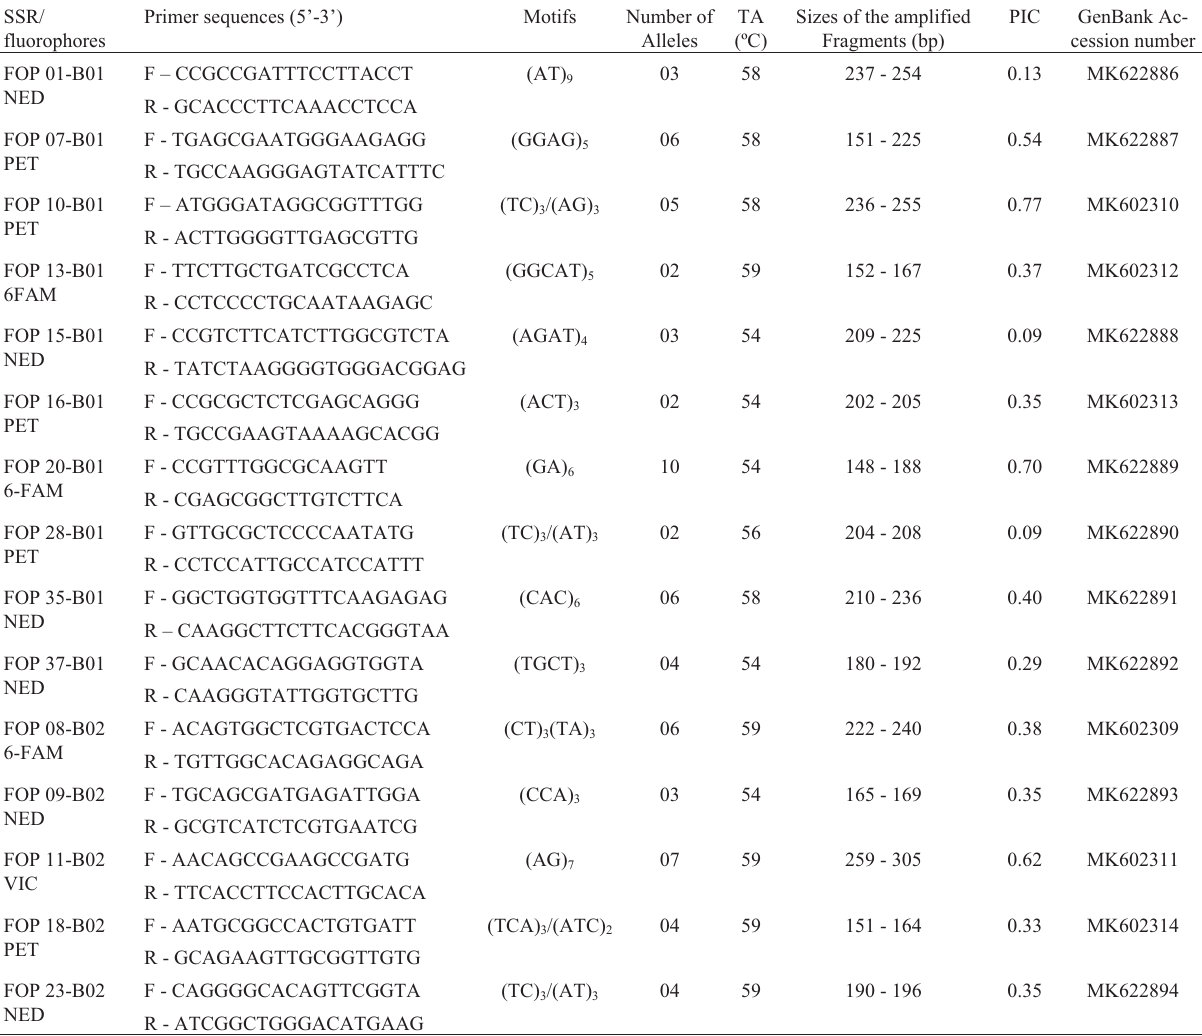
Table 2 - Characteristics (the 5’ end labeling fluorophores; F: the forward primer sequences; R: the reverse primer sequences; T a: annealing temperature; sizes of the amplified fragments in base pairs-bp) of the microsatellites (SSRs) developed for Fusarium oxysporum f. sp. phaseoli isolates. SSR/ Primer sequences fluorophores